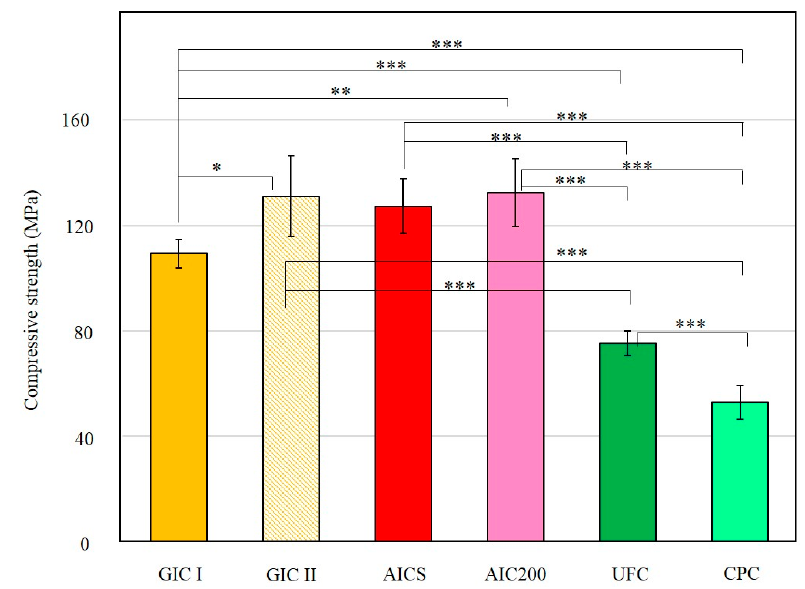
Figure 2. After stored in artificial saliva at 37 °C for 23 h, the compressive strength data obtained from the Experiment II ( n = 6/group); * p < 0.05; ** p < 0.01; *** p < 0.001.